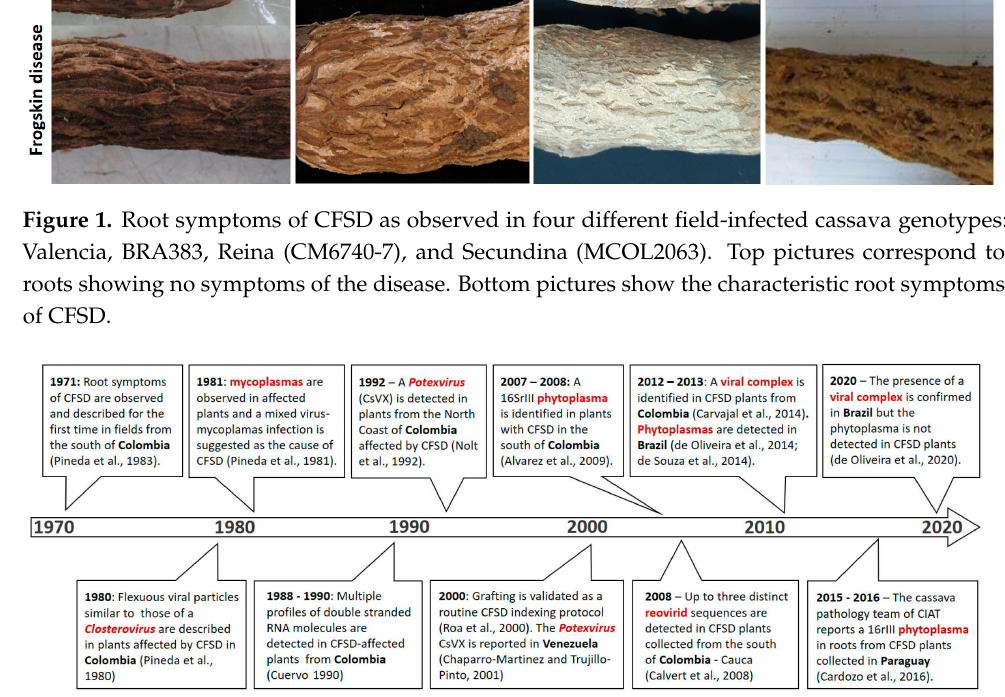
Figure 2. A timeline of the main results on the search for the causal agent of CFSD.